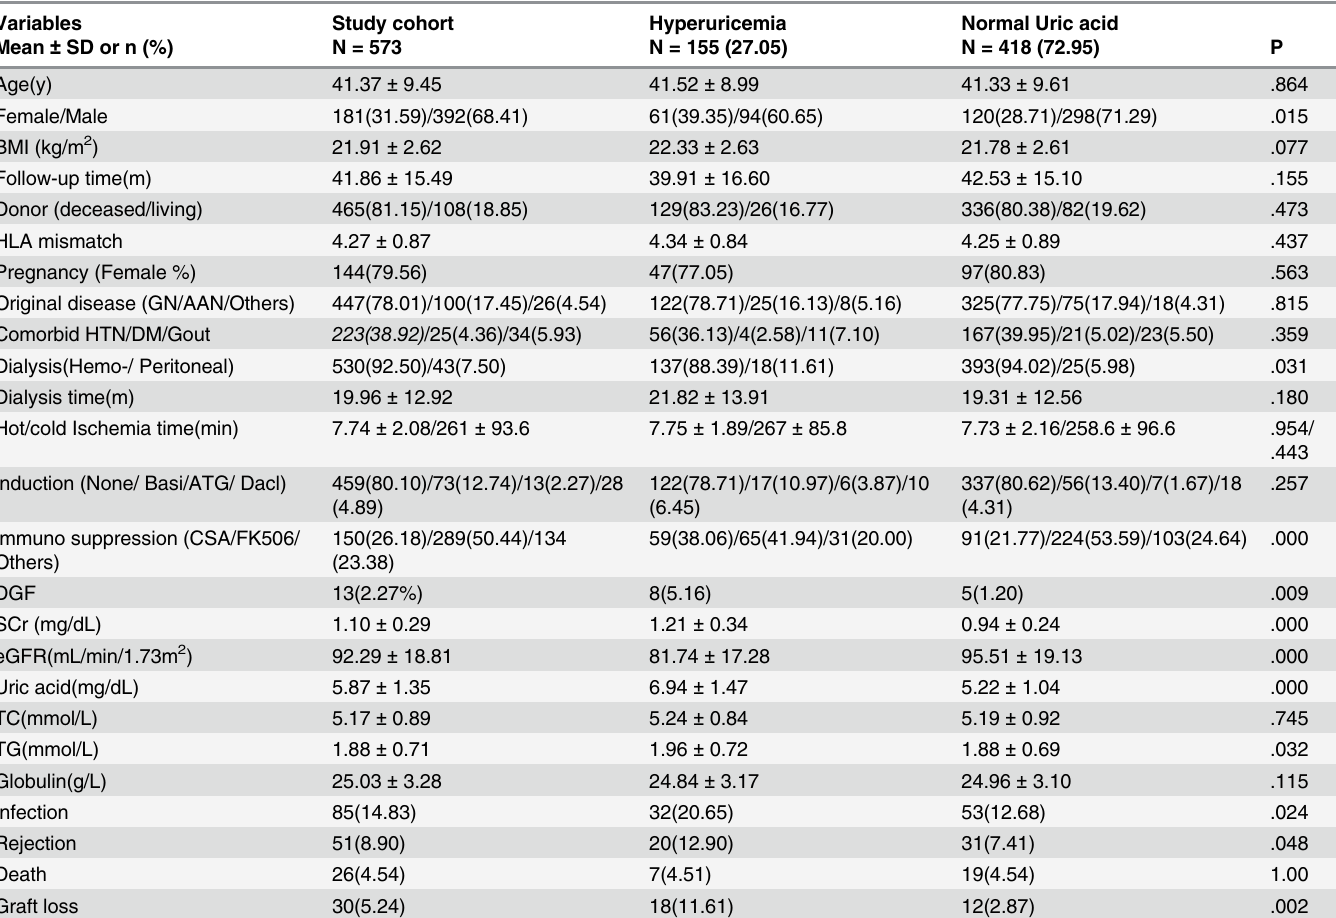
Table 1. Demographic characteristics and laboratory findings of the recruited patients. BMI: Body mass index; HTN: Hypertension; GN: Glomerulone- phritis; AAN: Aristolochic acid nephropathy; Basi: Basiliximab; Dacl: Daclizumab; DGF: delayed graft function SCr: Serum creatinine TC: Total cholesterol; TG: Triglycerides;